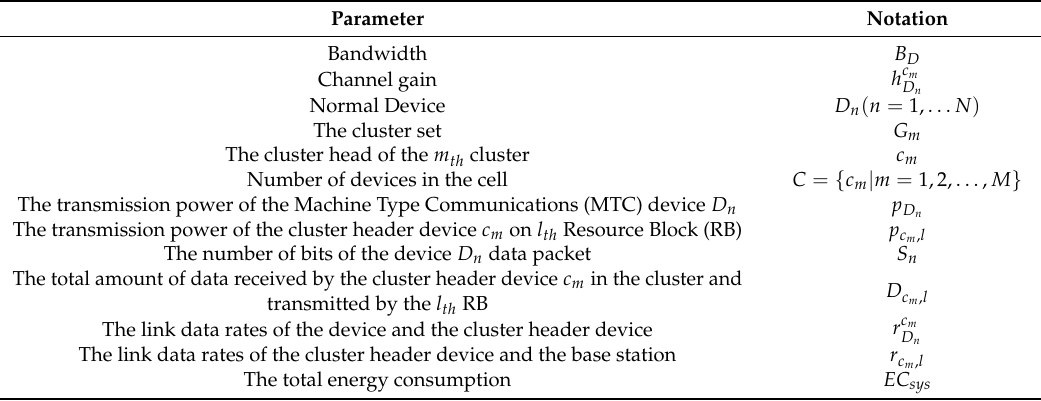
Table 1. Notations introduced in system